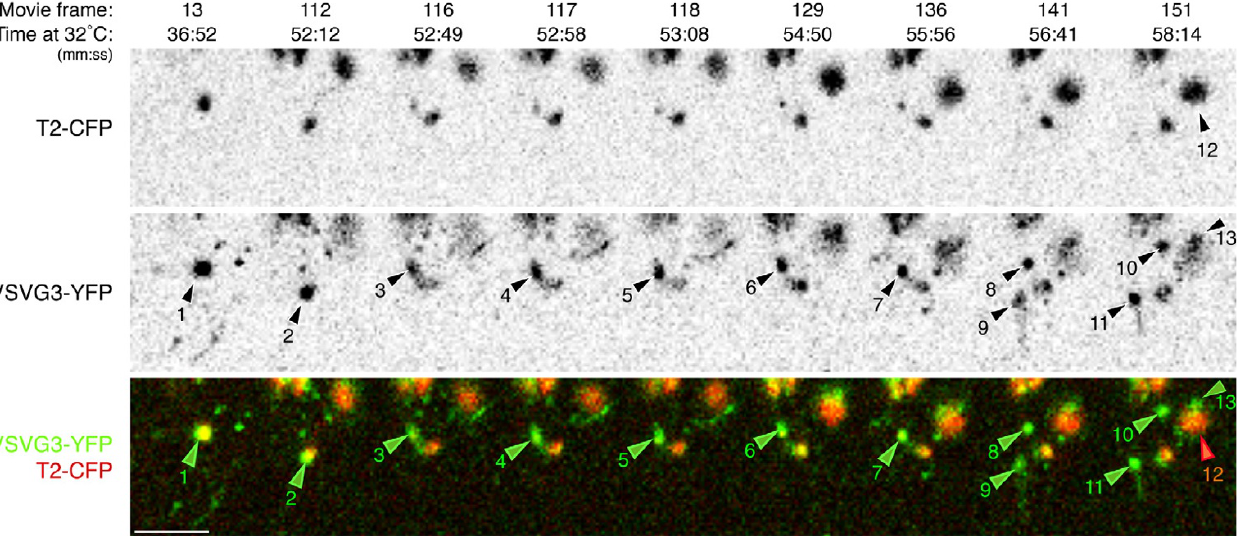
Figure 6 Post-Golgi carriers can be as large as the Golgi elements from which they originate Transiently expressed VSVG3- YFP cargo was accumulated in the ER and pulsed into the secretory pathway of PtK 2 cells as in Figure 1B. Time at 32 ° C and the frame number of the corresponding movie are indicated (Additional Fileset 6). Cargo and Golgi resident coincide in a discrete Golgi element (1) . A cargo domain forms (2) which extends (3) , rapidly pulls off of the Golgi element (4) , and recondenses (5 to 7 ) to a spherical TC of a size similar to the original Golgi element. The TC translocates away from the Golgi element (8) as another large TC enters the field of view (9) , and appears to interact with the element (Additional Fileset6). The first TC con- tinues to translocate away (10) . A nearby Golgi element (12) has a cargo domain (13) which displays obvious coincident dynam- ics. Bar: 10 µ